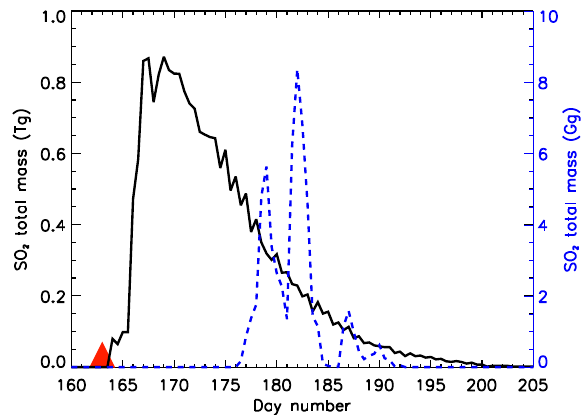
Fig. 1. Temporal evolution of the SO 2 total mass over the Kiruna Fig.1. Temporalevolutionofthe SO 2 totalmassovertheKirunaregion(bluedashedline, ± 10˚lat-lonbox,inGg)andNorthernHemisphere (blackline,inTg)observedbytheIASIinstrumentonboardtheMETOP-Asatellitefrom9Juneto24July2009. TheSarycheveruptionis region (blue dashed line, ± 10 ◦ lat–long box, in Gg) and Northern symbolizedbytheredtriangle. Hemisphere (black line, in Tg) observed by the IASI instrument on board the METOP-A satellite from 9 June to 24 July 2009. The Sarychev eruption is symbolized by the red